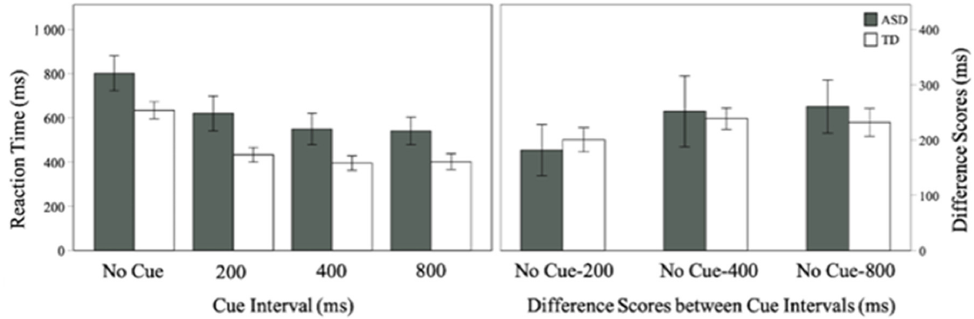
Figure 2. Reaction times showing both groups are faster to respond when tactile cues are present (left) and difference scores between touch cue intervals (right). Error bars represent ± 1 SE of the